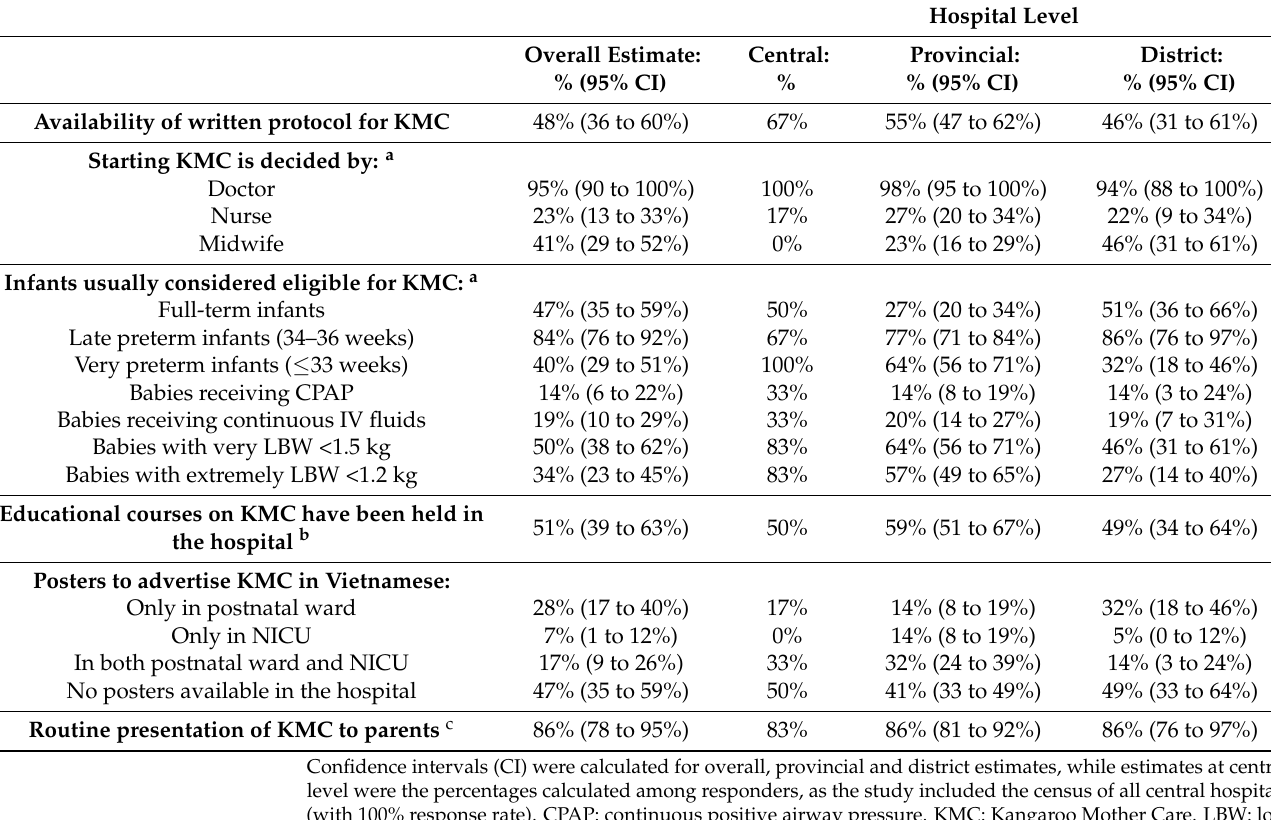
Table 2. Organizational aspects of Kangaroo Mother Care (in hospitals where KMC is routinely performed or planned to be introduced in the next 12 months).